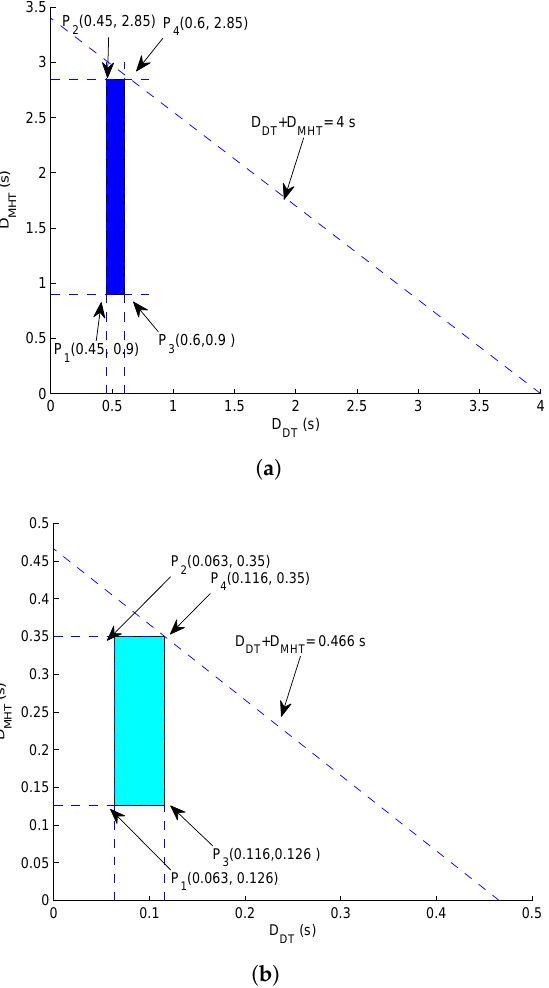
Figure 7. Feasible regions. ( a ) End to end delay: feasible region for GDGOR-IA; ( b ) end to end delay: feasible region for